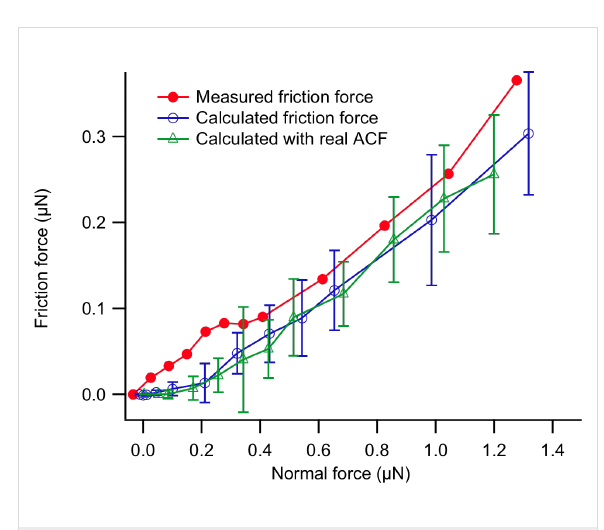
Figure 4: The average friction force (determined as depicted in Figure 3) as a function of the normal load is more or less linear on the scale of MEMS devices. The tests were conducted at 27 °C and a rela- tive humidity of 30%. The fitted friction coefficient is 0.27. Indicated are also the calculated friction force based on an exponential autocorrela- tion function, with blue open circles, and with the measured autocorre- lation function (‘real ACF’), indicated with green open triangles. The effect of the choice of autocorrelation function is very